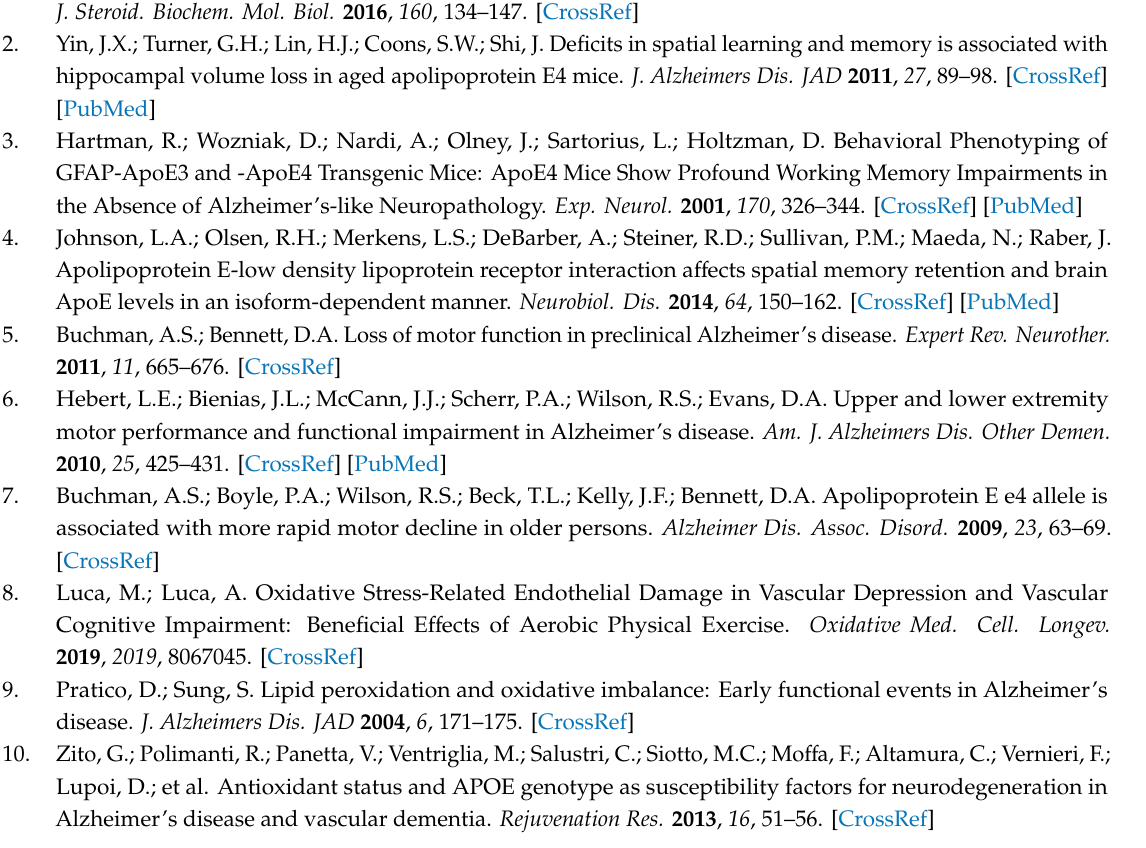
Figure S1: E ff ect of exercise and antioxidant on performance on the elevated plus maze in male and female GFAP-ApoE3 and GFAP-ApoE4 mice, Figure S2: E ff ect of exercise and antioxidant on spontaneous activity in male and female GFAP-ApoE3 and GFAP-ApoE4 mice, Figure S3: E ff ect of exercise and antioxidant on reflexes in male and female GFAP-ApoE3 and GFAP-ApoE4 mice, Figure S4: E ff ect of exercise and antioxidant on catalase activity from di ff erent brain regions from GFAP-ApoE3 and GFAP-ApoE4